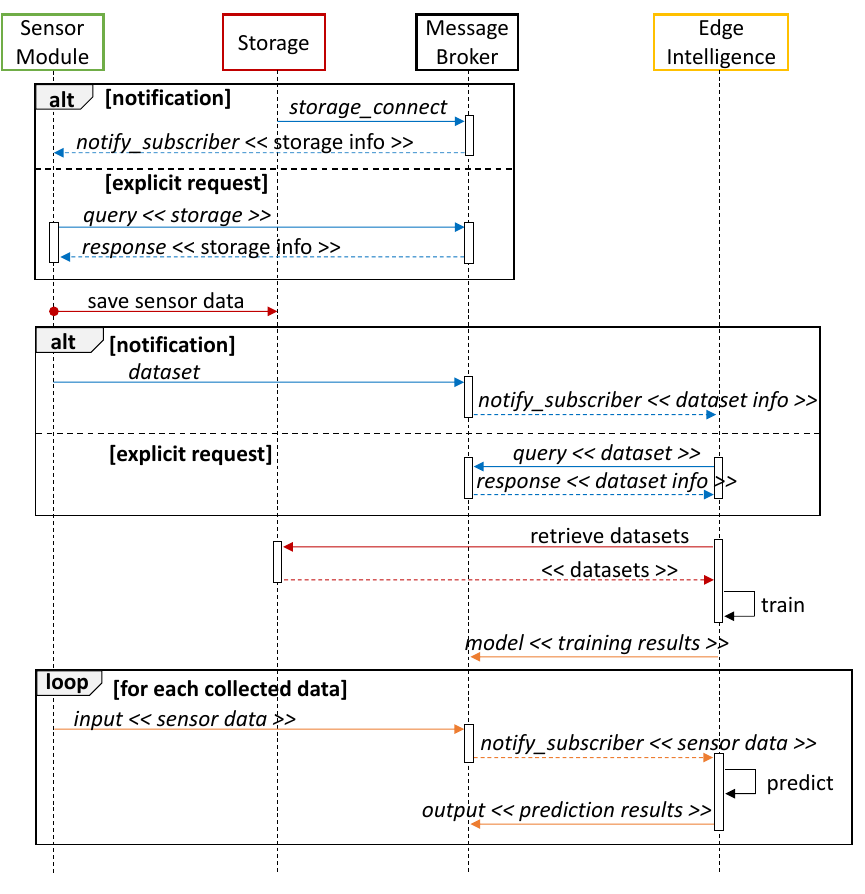
Figure 4. Sequence diagram for Edge-side